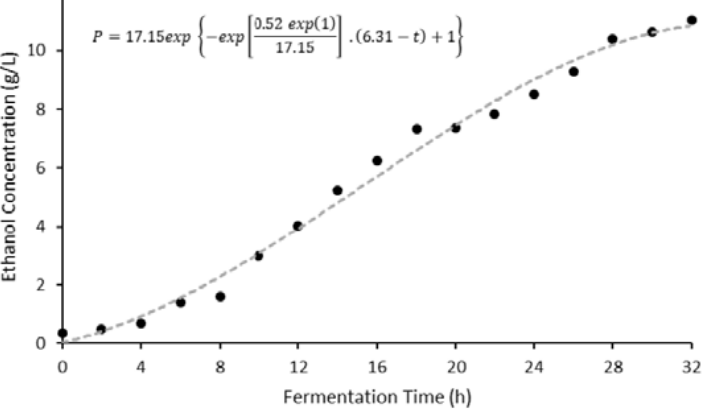
Figure 3. Average glucose utilisation and ethanol formation during batch fermentation by S. cerevisiae BY4743.